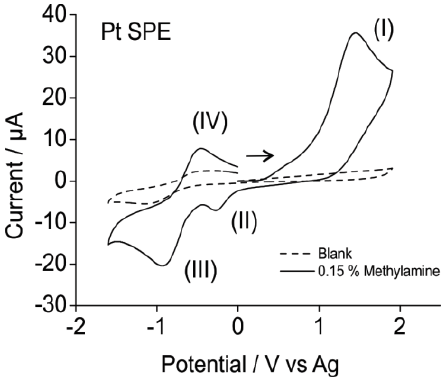
Figure 1. CV for the oxidation of 0.15% methylamine gas on a Pt SPE in [C 2 mim][NTf 2